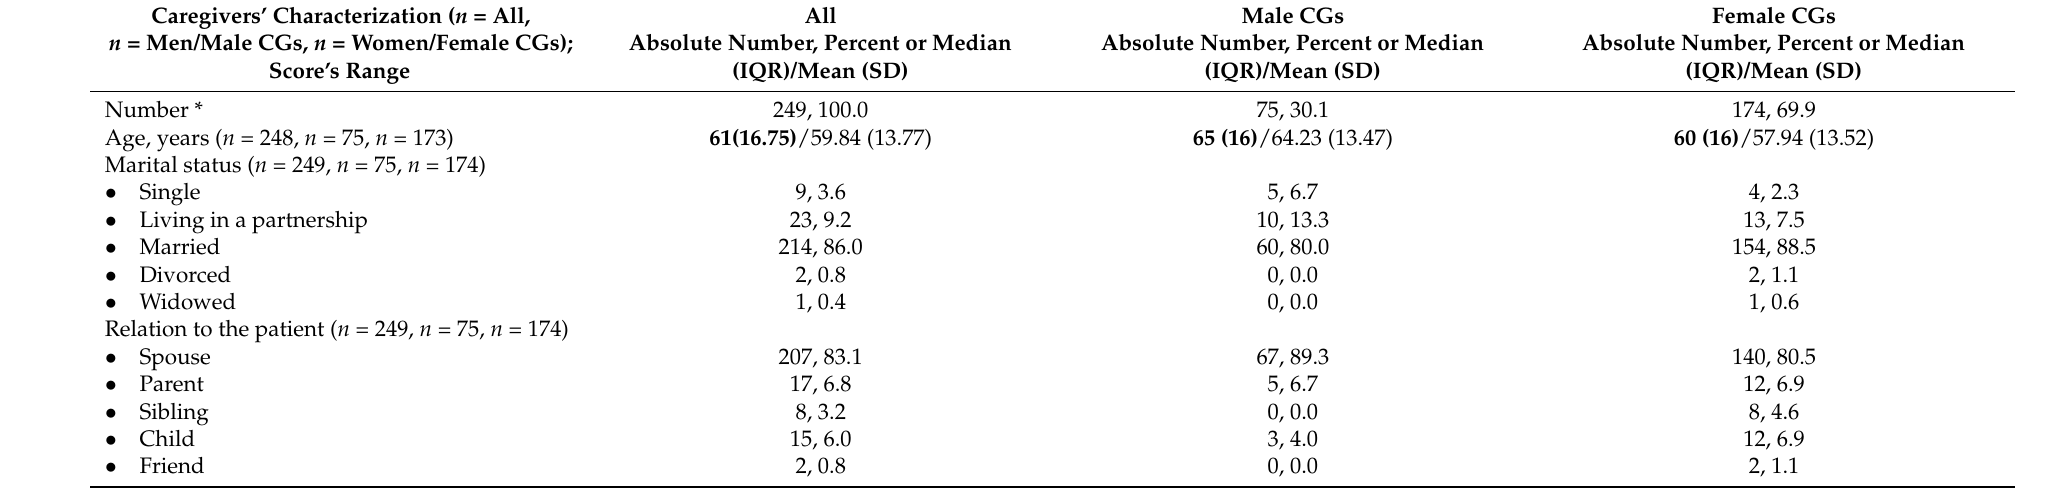
Table 2. Caregivers’ characterization. This table shows the caregivers’ characteristics, their care-related burden (ZBI score), their HRQoL (EQ-VAS score/EQ-5D-5L index value), and their depression and anxiety (HADS-D/HADS-A scores). Due to rounding, the percentage might not add up to 100 exactly. * = Since some data (e.g., the ZBI of seven CGs) was unknown, not all numbers add up in total and result in different n . Abbreviations: n = number; CGs = caregivers; IQR = interquartile range; SD = standard deviation; ALS = Amyotrophic